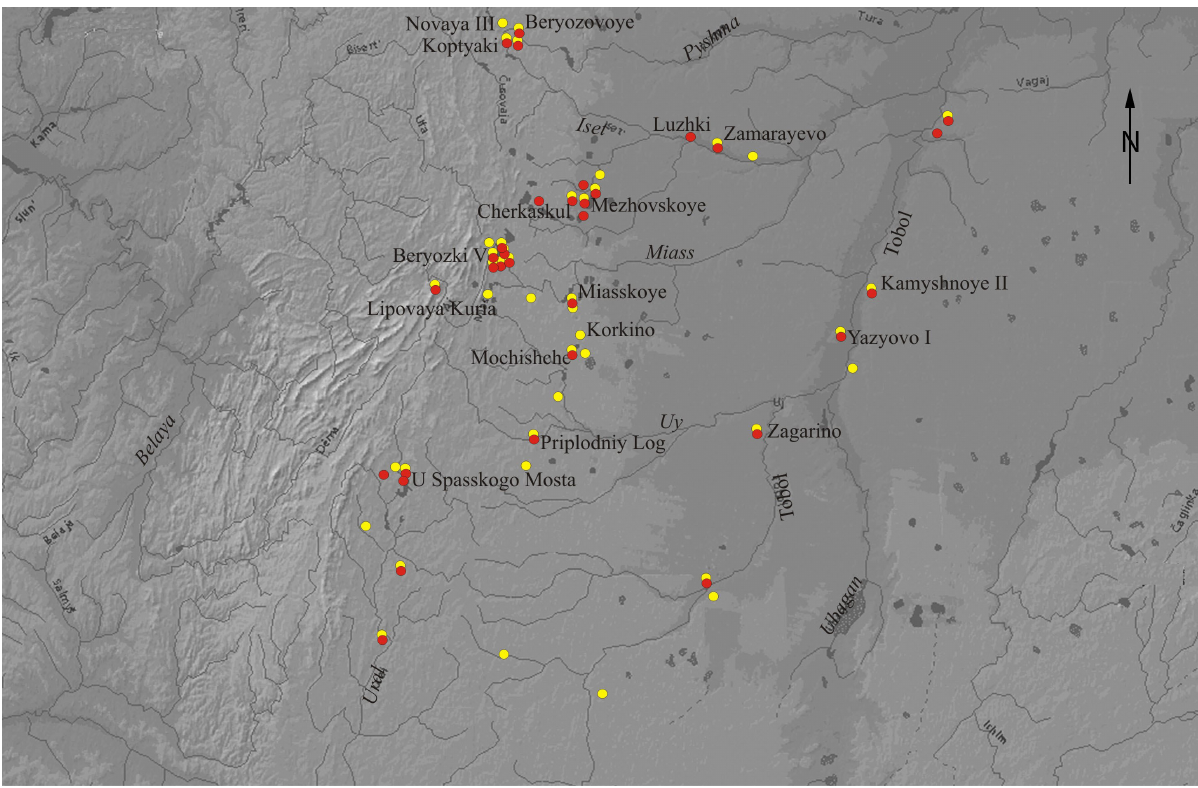
Figure 23: Map of the distribution of Cherkaskul (yellow circles) and Mezhovka (red circles) sites in the Southern Transurals. The border between the steppe and forest-steppe is along the Uy River and along the Ural Mountains (after Grigoriev,